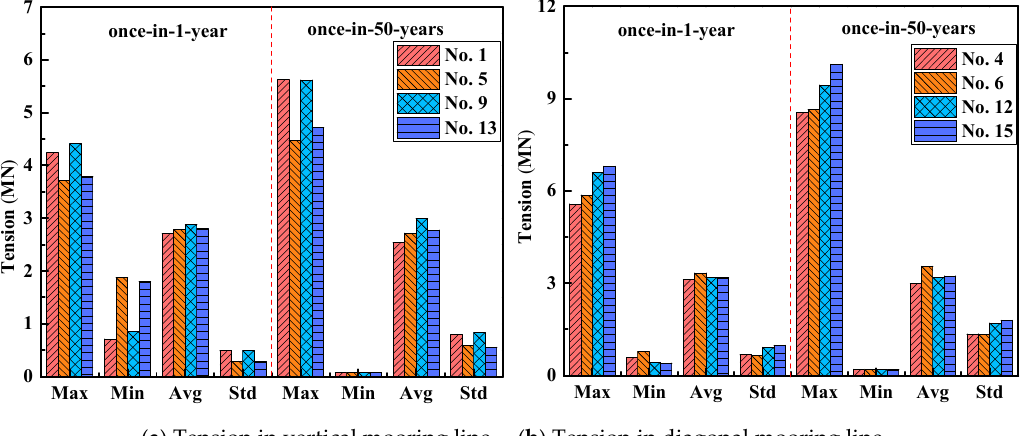
Figure 19. Statistics of tension in the mooring lines under extreme sea-states.